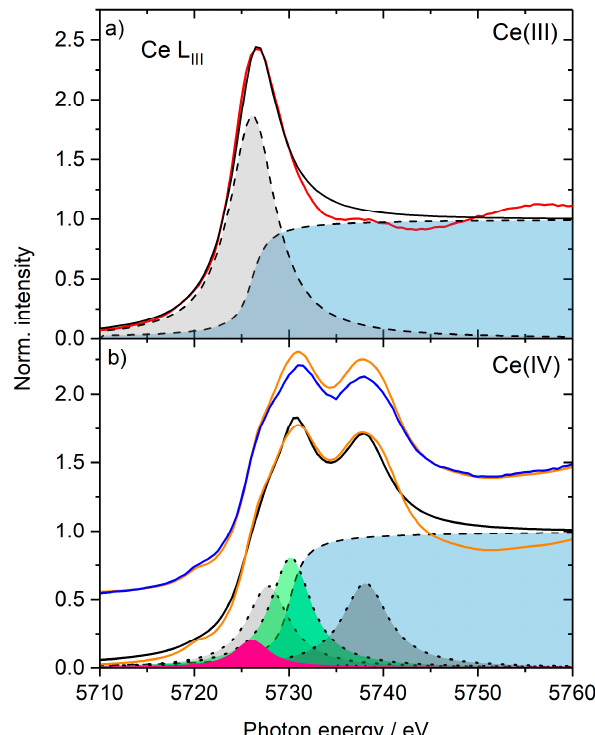
Figure 1. X-ray absorption spectroscopy (XAS) measurements in the near edge region (XANES) spectra recorded at the Ce L III edge (measured at 80 °C in N 2 ): ( a ) of the Ce (III) reference (Ce 2 (CO 3 ) 3 × H 2 O, red line); ( b ) of the Ce(IV) reference (CeO 2 ) (blue line) and reference data published by Ravel and co-workers (orange lines) [44]. The dashed curves represent the main individual components of Ce as published by Yoshida et al. [45], the solid black lines denote a fit based on these components to our data. For an acceptable agreement with our Ce(IV) reference (blue) the component marked in red, which represents the white line in Ce (III), had to be increased in intensity compared to the fit to Ce(IV) data published by Yoshida (black).